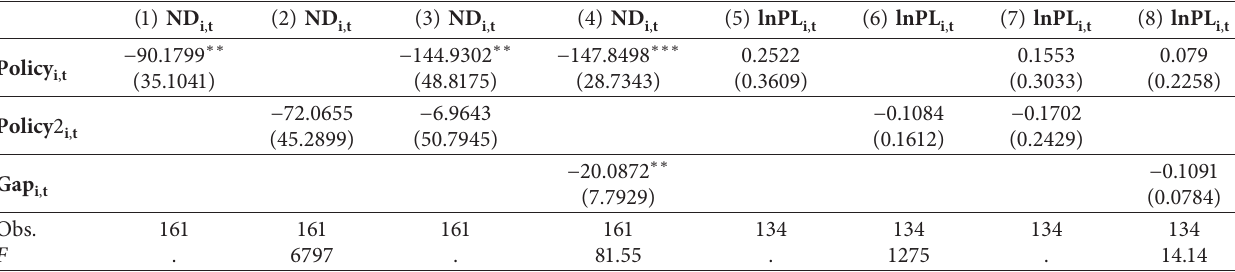
Table 10: The regression results of equations (2) and (3) (except for